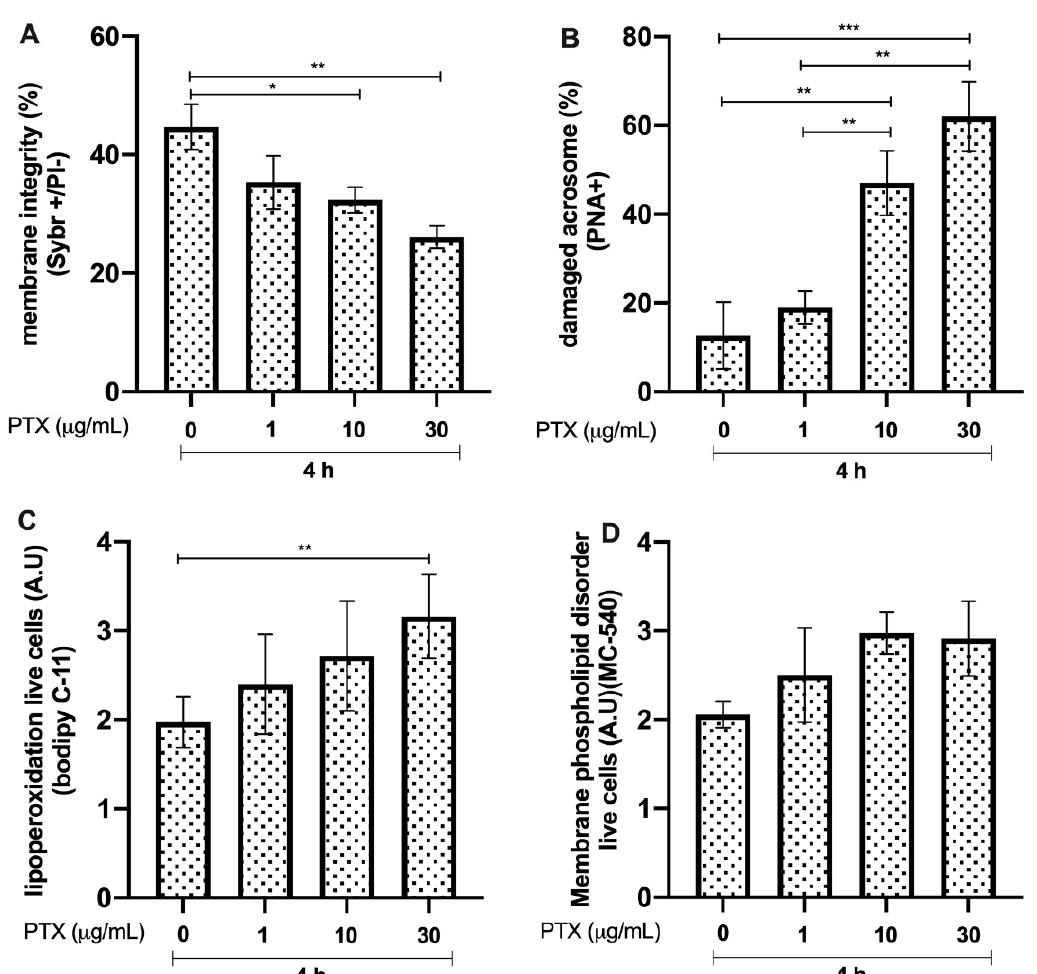
Figure 7. Effect of different concentrations of pentraxin 3 (PTX) on bull sperm. ( A ) Plasma membrane integrity. ( B ) Damaged acrosomes. ( C ) Lipid peroxidation. ( D ) Sperm membrane fluidity. The results are shown as the mean ± standard deviation. The asterisks (*, **, ***) above the bars indicate differences between the groups ( p < 0.05, p < 0.01, and p < 0.0001) based on three biological replicates.